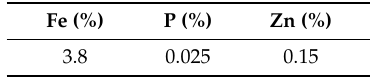
Table 3. Composition of Cu matrix in alloying element-enriched regions.